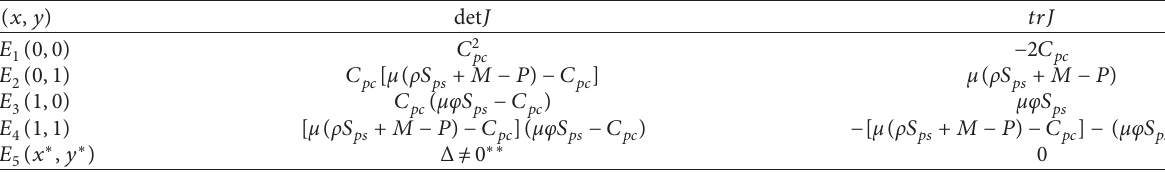
Table 3: The Jacobian determinant value and the trace.